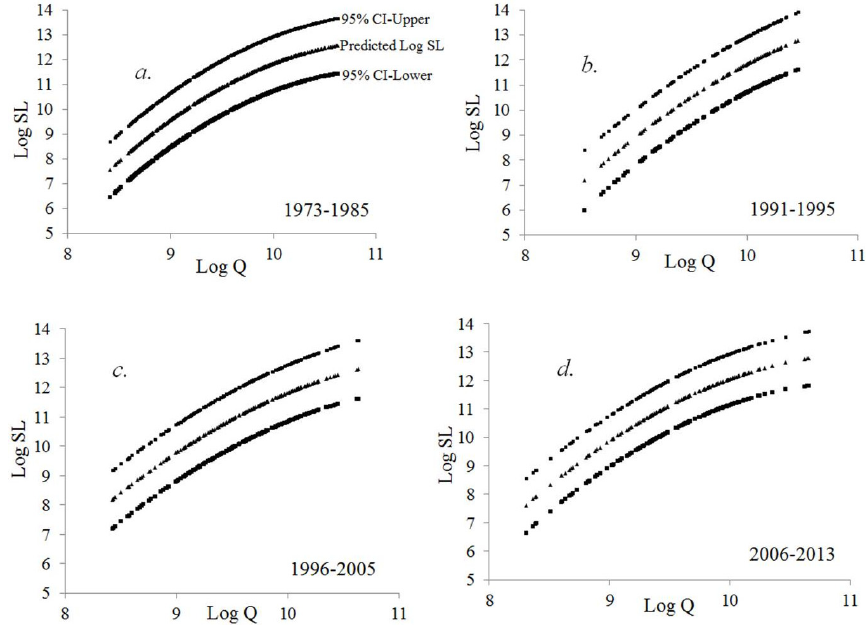
Figure 5. Confidence interval (CI) for the all “ln predicted SL” values at 95% confidence level in accordance to their corresponding SSC s - Q d rating curves during the four periods as shown at Tarbert Landing. It is noted that in all four periods ( a ), ( b ), ( c ) and ( d ), uppermost and lowermost curves represent the upper and lower limits of the CI, while the middle curve represents all individual “ln predicted SL” values as given in a .